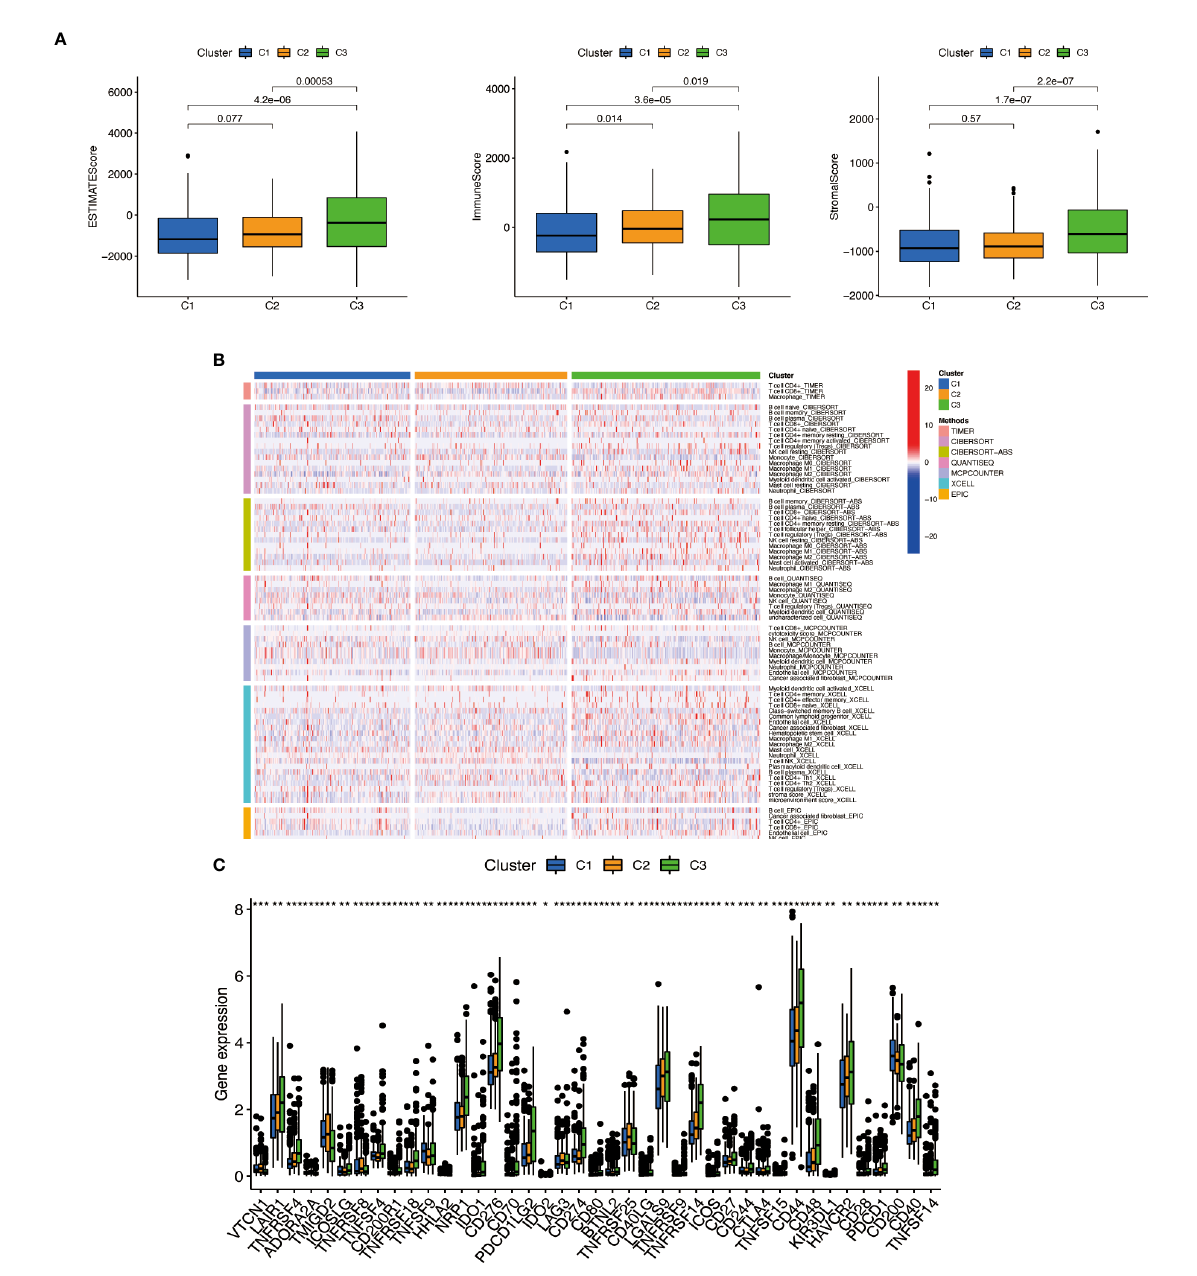
FIGURE 13 Cluster immune correlation analysis. (A) Stromal cells and immune cells had a higher degree of in fi ltration in Cluster 3. (B) An immune-related heat map shows more in fi ltration of immune cells at Cluster 3. (C) The result of immune gene checkpoints. * if p < 0.05, ** if p < 0.01, and *** if p <